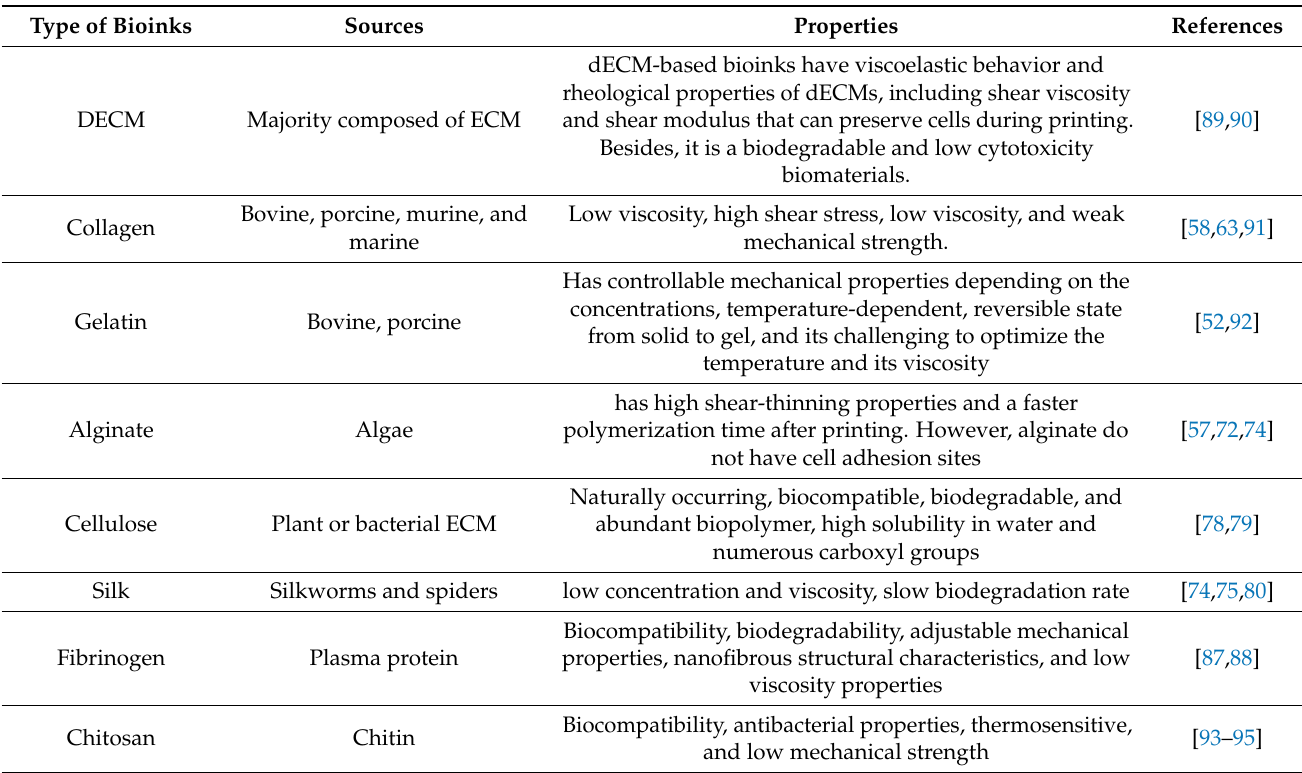
Table 1. Properties of natural-based